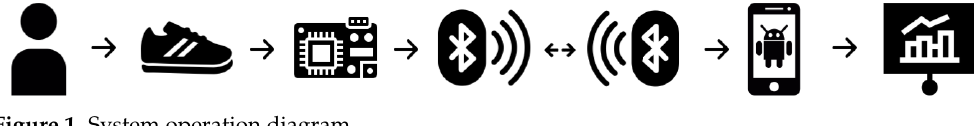
Figure 1. System operation